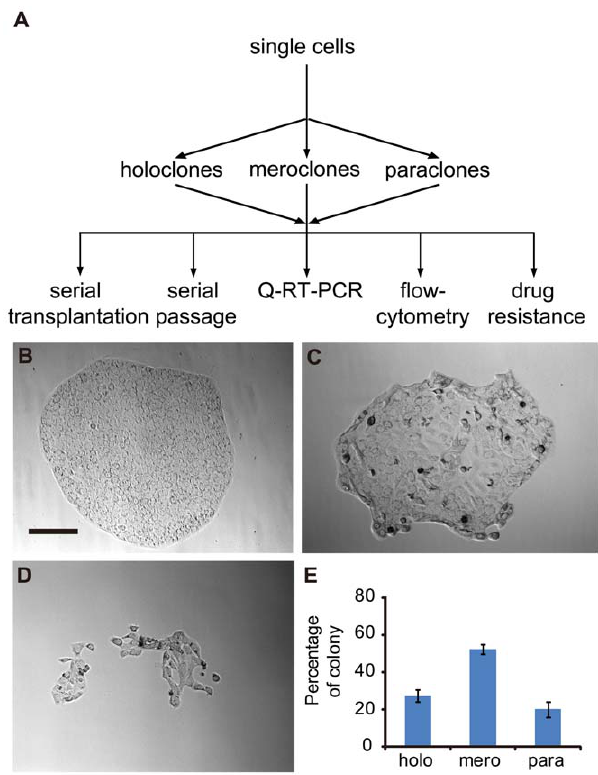
Figure 1. Colony heterogeneity in pancreatic cancer cell line BxPC3. (A) Schematic depicting the procedure of deriving BxPC3 cell clonal cultures and functional assays. Lower panels show representative holoclones (B), meroclones (C) and paraclones (D) from BxPC3 cultures. All photographs were taken at 2 weeks after plating (Bar, 100 microns). At this time point, each type of colonies was counted (E). The results from repeated experiments (n=4) are presented as means 6 s.e.m in histogram.